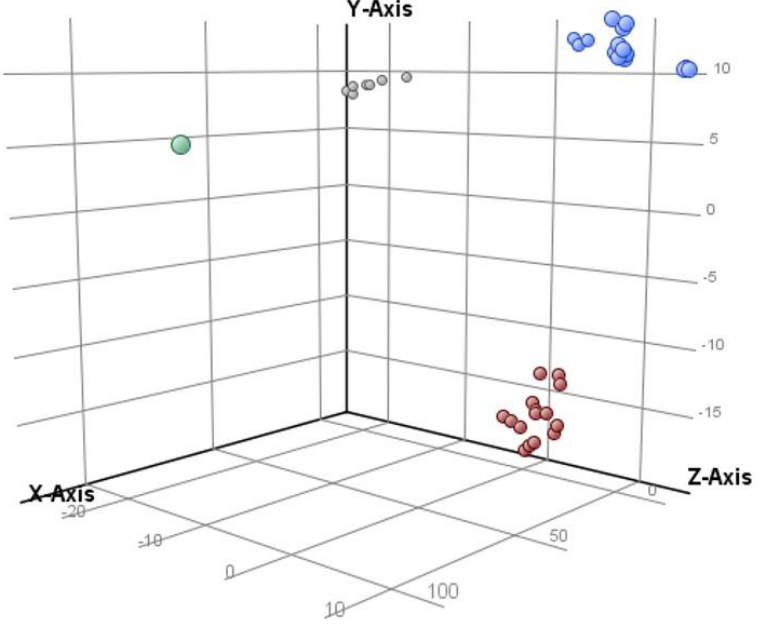
Figure 1. Principal component analysis on all entities and all samples. Component 1: 40.03% (x-axis), component 2: 17.34% (y-axis), and component 3: 11.88% (z-axis). Blank (green), MCF-7 (blue), MDA-MB-231 (red), and QC (gray).